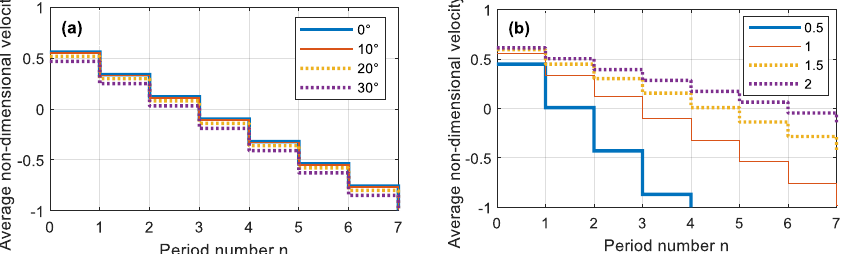
Figure 3. Average non-dimensional conveying velocity (𝑣̃ 𝑟 𝑥 0 𝜔⁄ ) versus period number, 𝜃 = 3° , 𝑎 𝑔⁄ = 1 and parametric values of 𝜓 ( a ); 𝜓 = 0 and parametric values of 𝑎 𝑔⁄ ( b ).